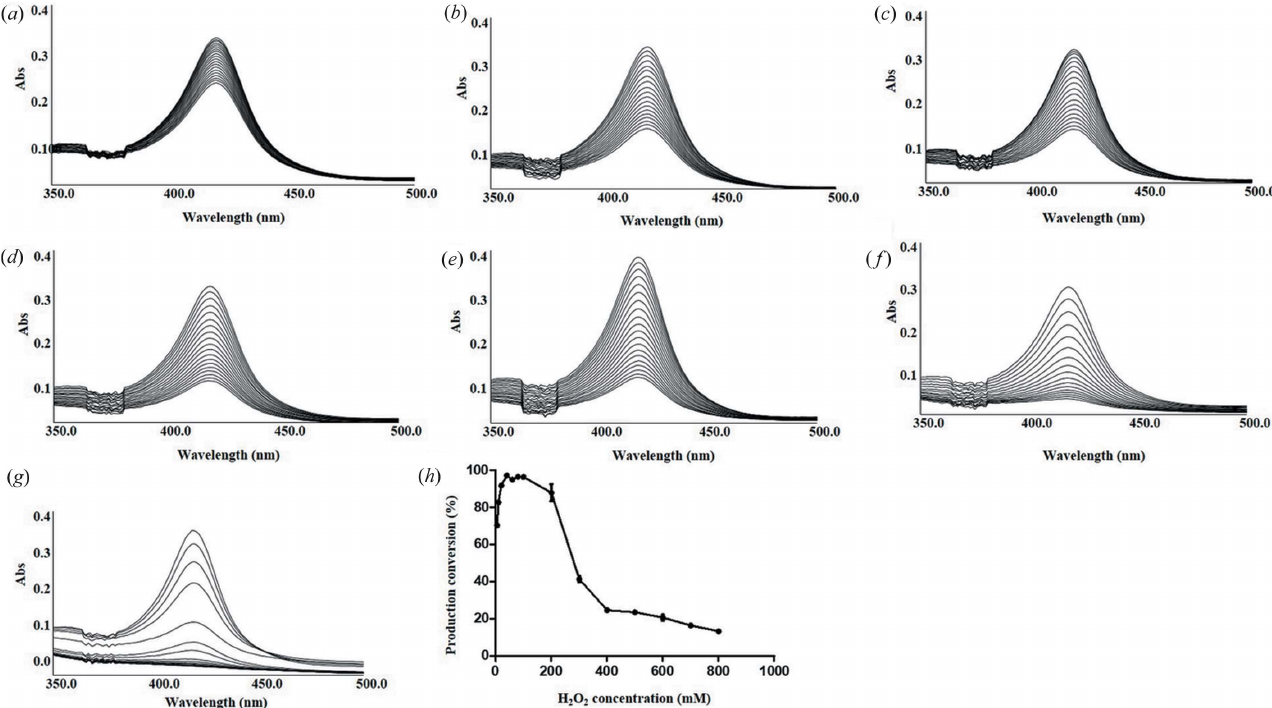
Figure 3 Heme oxidation pattern of CYP105D18 in the presence of different concentrations of H 2 O 2 . ( a ) 1 m M , ( b ) 5 m M , ( c ) 10 m M , ( d ) 20 m M , ( e ) 40 m M , ( f ) 100 m M and ( g ) 200 m M H 2 O 2 . The concentration of CYP was fixed at 3 m M . The decrease in the Soret peak (417 nm) was measured at 90 s intervals for 30 min. Optimization of H 2 O 2 concentrations for in vitro papaverine N-oxidation by CYP105D18 ( h ). The reaction conditions were as follows: 3 m M CYP, 400 m M substrate and 5–800 m M H 2 O 2 . The means and standard deviations were obtained from three independent reactions with similar